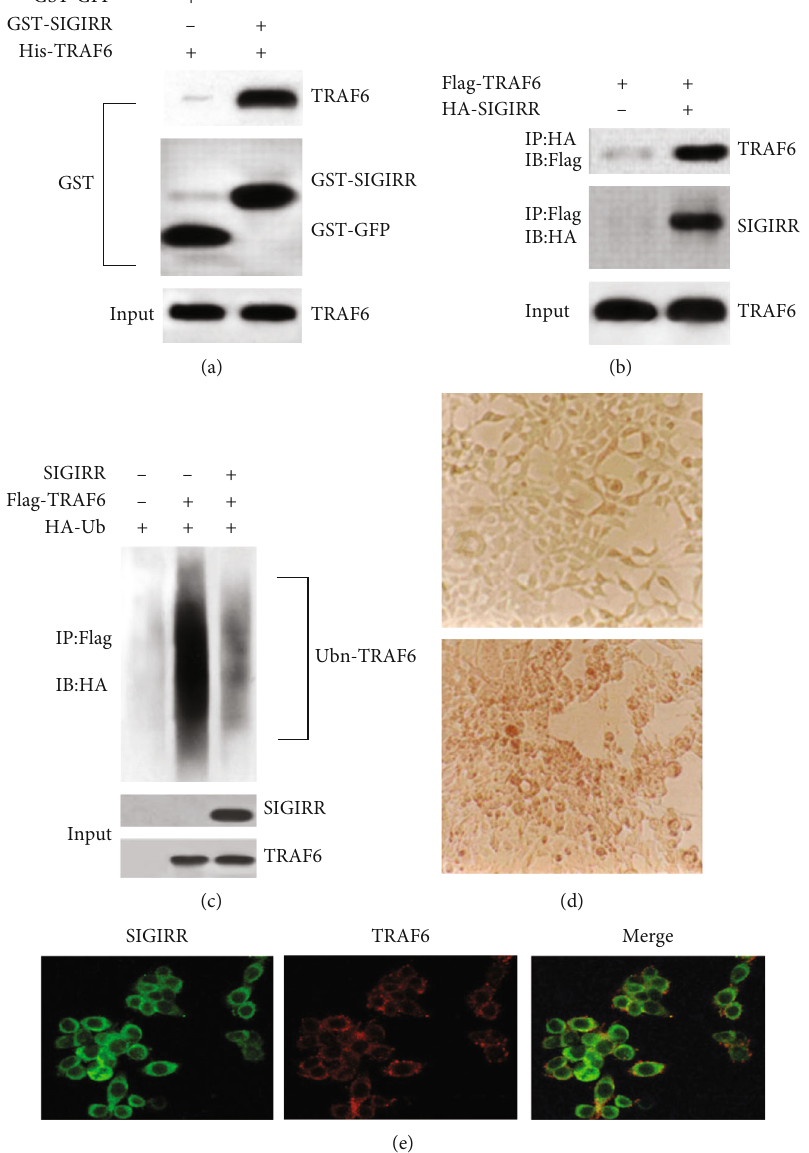
Figure 1: Analysis by pull-down and coimmunoprecipitation experiments of the interaction between SIGIRR and TRAF6 and resultant (auto) ubiquitinylation of TRAF6. (a) GST pull-down assay was performed using puri fi ed GST-fusion SIGIRR and His-tagged TRAF6 proteins. (b) A lysate from HEK293 cells cotransfected with Flag-TRAF6 or HA-SIGIRR was subjected to immunoprecipitation with anti- HA or anti-Flag antibody, respectively. (c) A lysate from HEK293 cells cotransfected with SIGIRR, Flag-TRAF6, or HA-ubiquitin, respectively, was subjected to immunoprecipitation with anti-Flag antibody. (d) HEK293 cells were cultured and cotransfected with the above regents. (e) Colocalization between SIGIRR and TRAF6 in HEK293 cells was also evaluated by immuno fl uorescence confocal